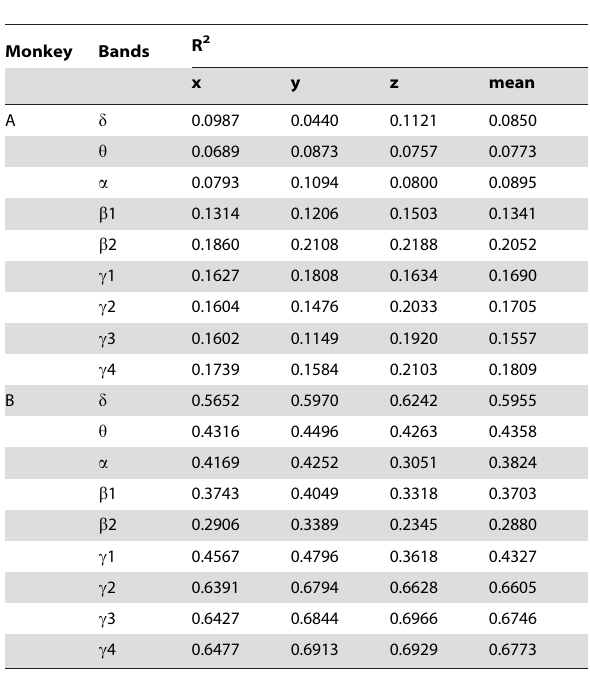
Table 3. Prediction results using individual frequency bands.